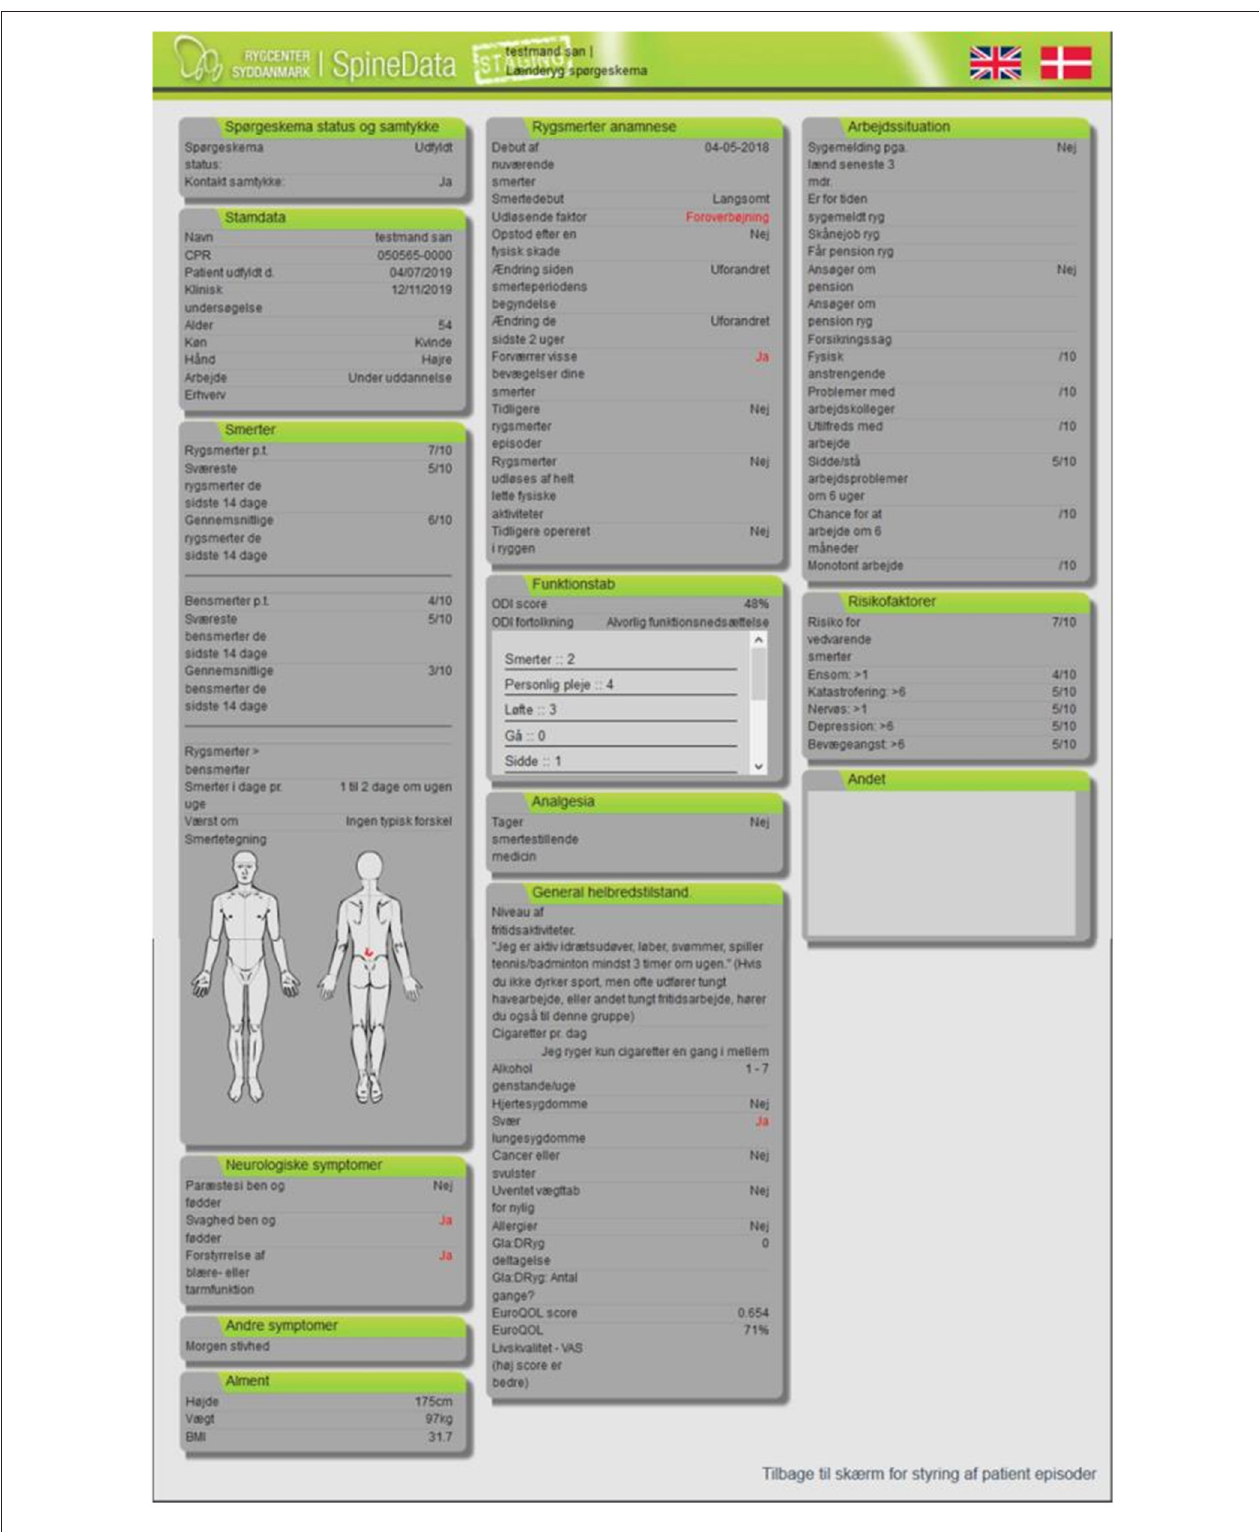
FIGURE 2 | Screenshot SpineData